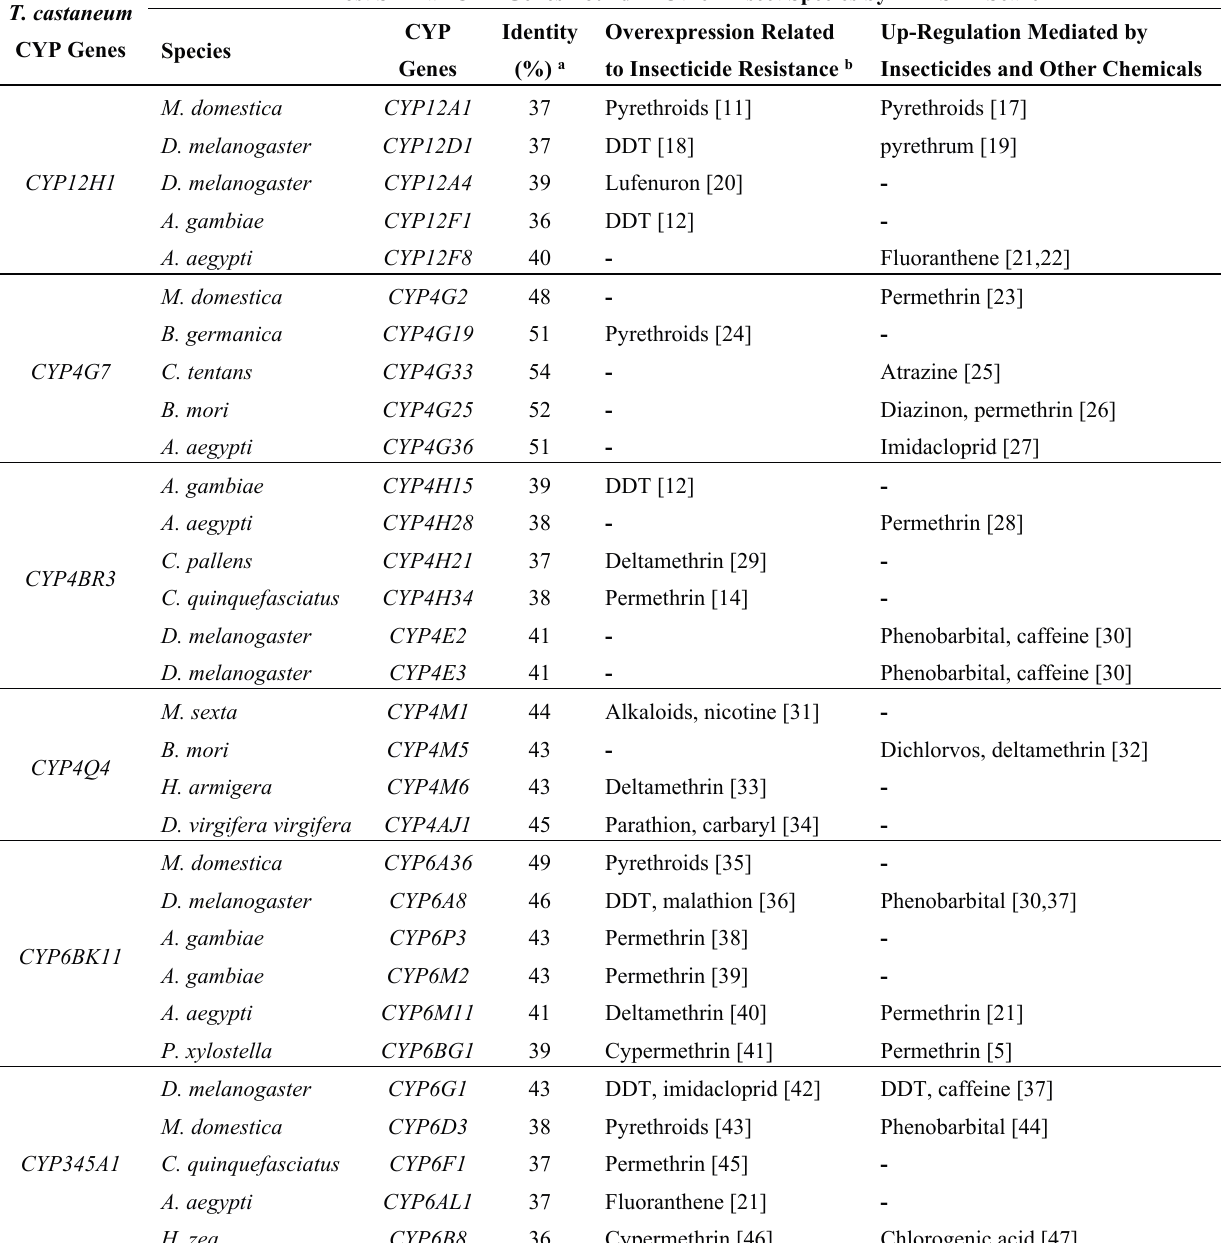
Table 1. Comparisons of selected cytochrome P450 (CYP) genes from T. castaneum with those known to be up-regulated by chemicals and/or overexpressed in insecticide resistant strains of other